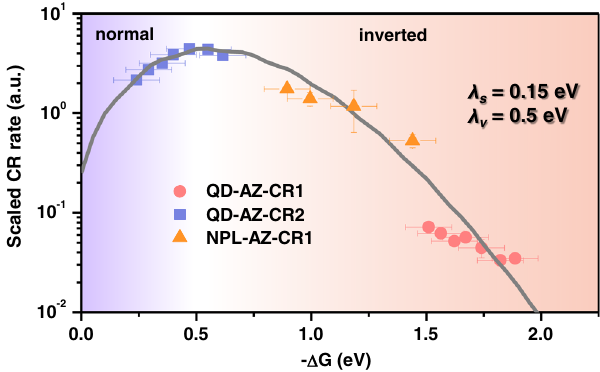
0.0 Fig. 6 Combination of the results for CR1 (red circles) and CR2 (blue squares) in CdS QD – AZ complexes and for CR1 (orange triangles) in CdSe NPL – AZ complexes. The gray solid line is a fi t to Marcus theory (Eq. 2). Horizontal error bars stand for the accuracy of the electrochemical experiments for energy levels (±0.1 eV), whereas vertical errors are the fi tting errors of the CR